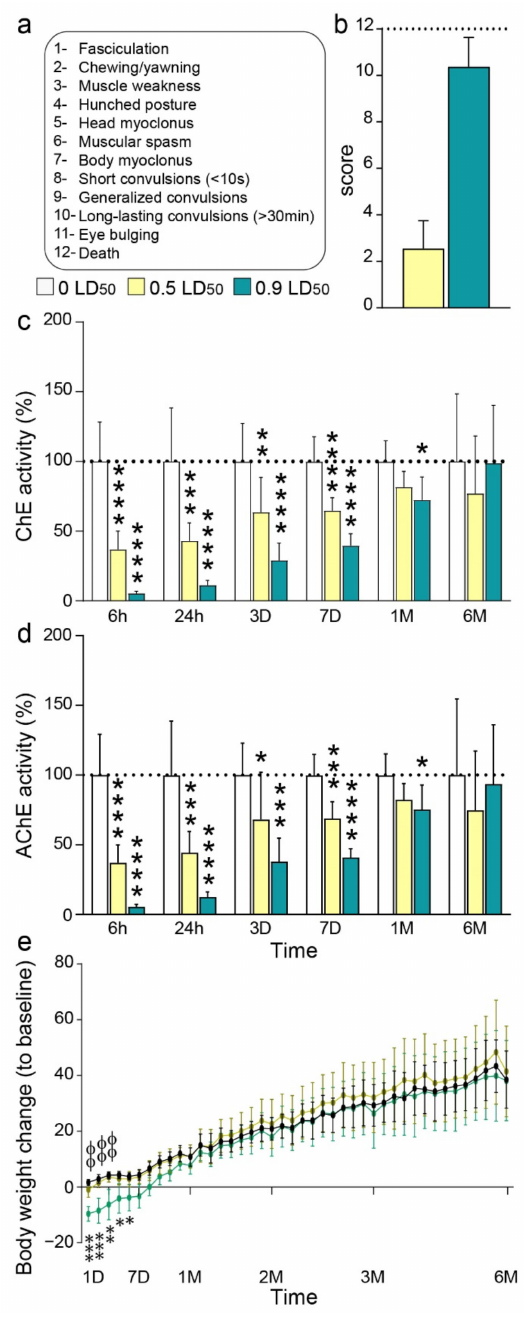
Figure 1. General effects of NIMP intoxication. ( a ) Intoxication scale based on the most relevant behavioral signs. ( b ) Average intoxication score induced by the two doses of interest: 2.55 ± 0.17 for 0.5 LD50 and 10.38 ± 0.16 for 0.9 LD50. ( c ) ChE activity at different timepoints post-NIMP exposure: 6 h (100 ± 11.5 for 0 LD50; 37.0 ± 4.6 for 0.5 LD50 and 5.4 ± 0.6 for 0.9 LD50); 24 h (100 ± 13.6 for 0 LD50; 43.0 ± 4.5 for 0.5 LD50 and 11.3 ± 1.3 for 0.9 LD50); 3 days (100 ± 9.6 for 0 LD50; 63.5 ± 8.8 for 0.5 LD50 and 29.0 ± 4.4 for 0.9 LD50); 7 days (100 ± 6.3 for 0 LD50; 64.8 ± 3.2 for 0.5 LD50 and 39.7 ± 3.3 for 0.9 LD50); 1 month (100 ± 6.7 for 0 LD50; 81.7 ± 5.0 for 0.5 LD50 and 72.5 ± 6.7 for 0.9 LD50) and 6 months (100 ± 17.2 for 0 LD50; 77.0 ± 13.7 for 0.5 LD50 and 98.9 ± 14.6 for 0.9 LD50); ( n = 8 per group). Significant differences were determined by one-way ANOVA (F = 51.45, p < 0.0001 for 6H; F = 26.45, p < 0.0001 for 24H; F = 19.82, p < 0.0001 for 3D; F = 42.6, p < 0.0001 for 7D; F = 4.99, p = 0.02 for 1M and F = 0.76, p = 0.48 for 6M) with Dunnett’s post hoc test compared to the CTL